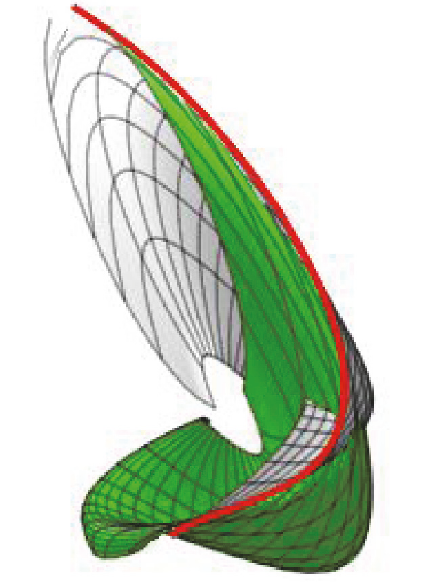
Figure10:Projectionof IS 𝛾 ± (𝑠,𝜇) (ingreenandingray)and C 𝛾 (𝑠) (in red) on 𝑥 2 𝑥 3 𝑥 4 -space.